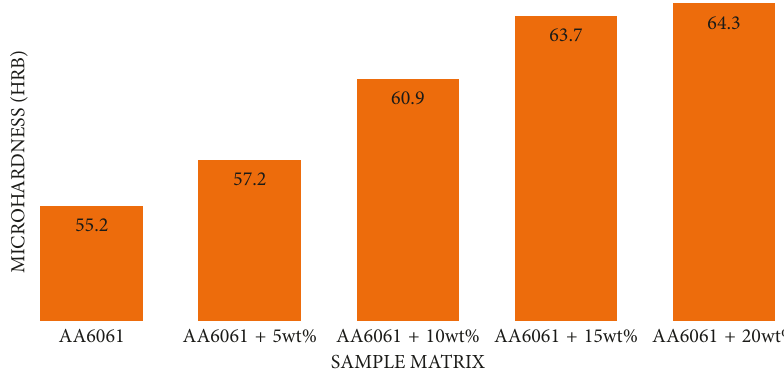
Figure 7: Effect of snail shells on the hardness of the reinforced aluminium composite.